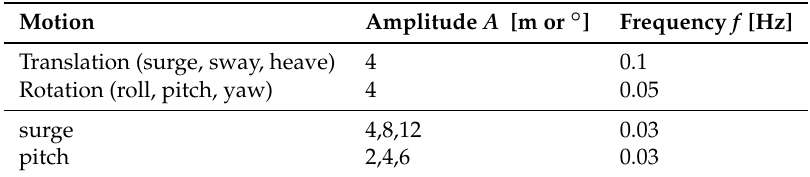
Table 2. Amplitude and frequency of prescribed single-DoF motions [6].